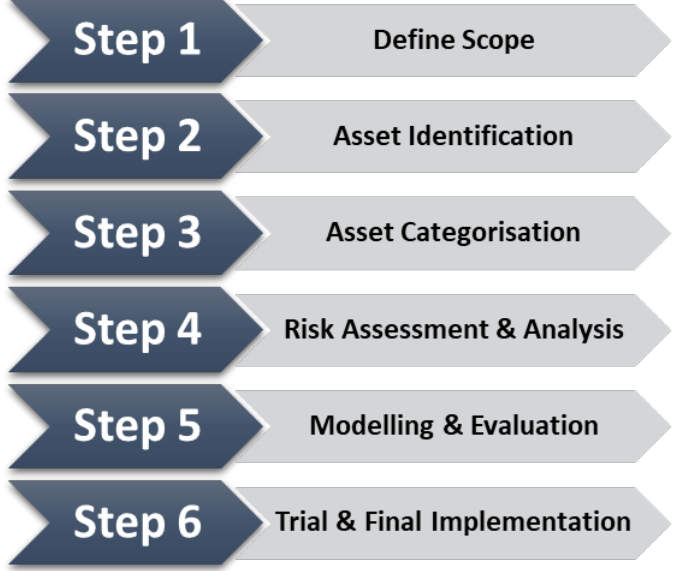
Figure 1. Overview of methodology process steps.